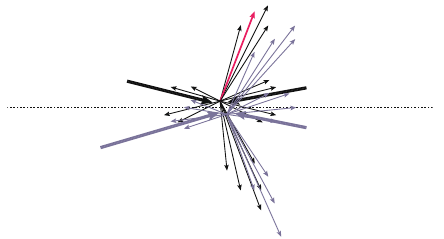
Fig. 15 Twohardcollisionswithtransversecorrelationsschematically represented by the transverse momentum exchange between incoming partons. The total transverse momentum does not sum up to zero for each subsystem, but overall is conserved